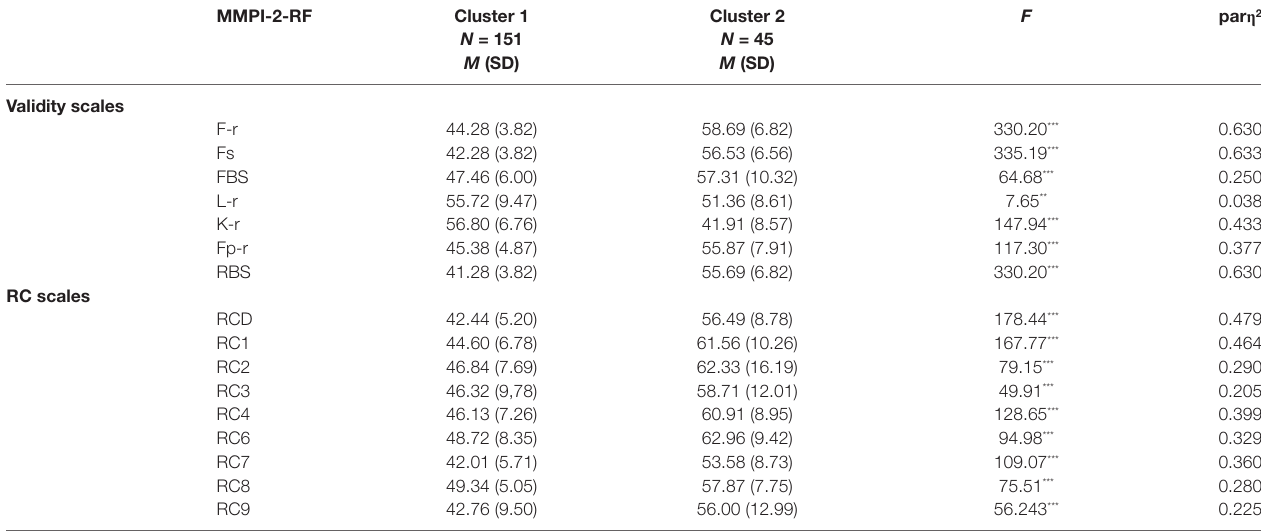
TABLE 5 | T-scores for the validity and RC scales of the MMPI-2-RF for Men-1 and Men-2 clusters.